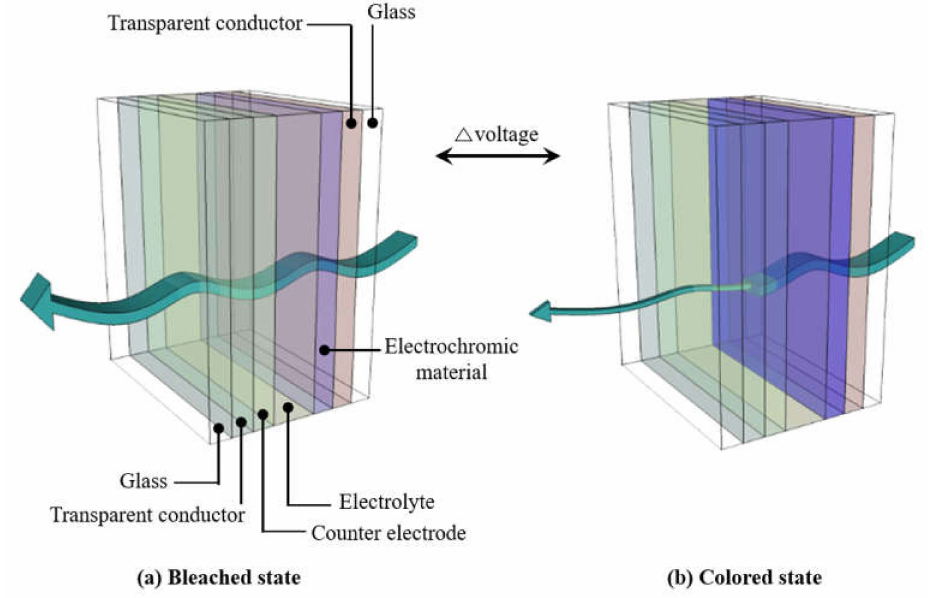
Figure 1. A schematic of a typical electrochromic